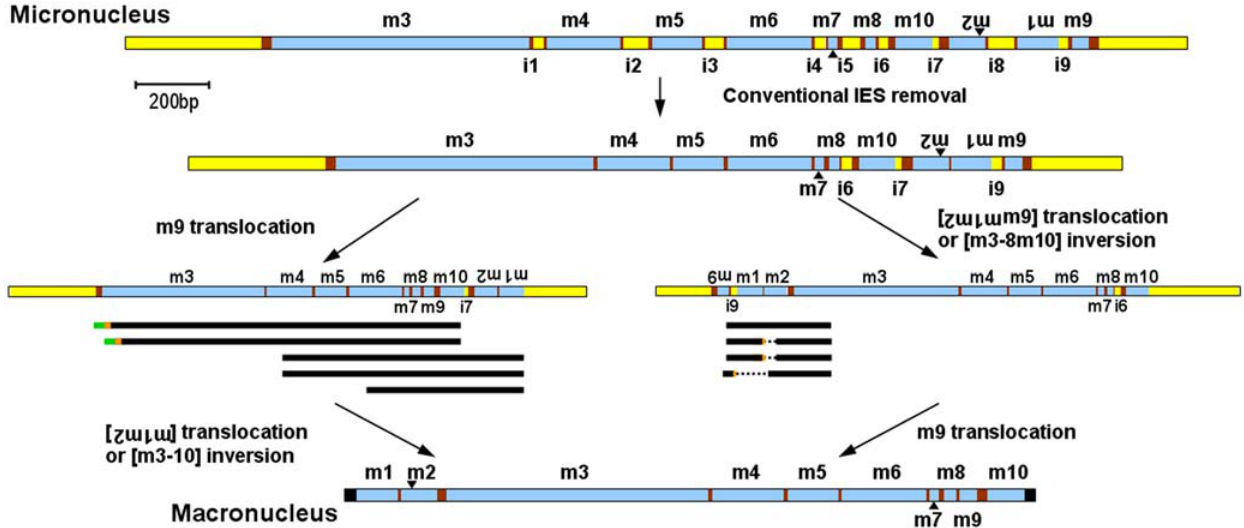
Figure 4. Model for two possible pathways to assemble the S.lemnaeactinI gene from its precursor form. The data suggest that conventional IES removal precedes unscrambling. Then unscrambling might occur via two alternative pathways that would pass through different transitional stages that are partially-rearranged. We found sequences (represented as black lines under alternative structures, see Figure S5 for details) that support the presence of both types of possible intermediates, suggesting that both pathways may occur, possibly non-deterministically. (Short green lines to the left of black lines represent small duplicated regions of MDS10, and dotted lines represent deleted sequences at cryptic pointers, in orange. Despite mistakes in their processing, these molecules are included in this analysis because they display general features consistent with a possible rearrangement pathway.)